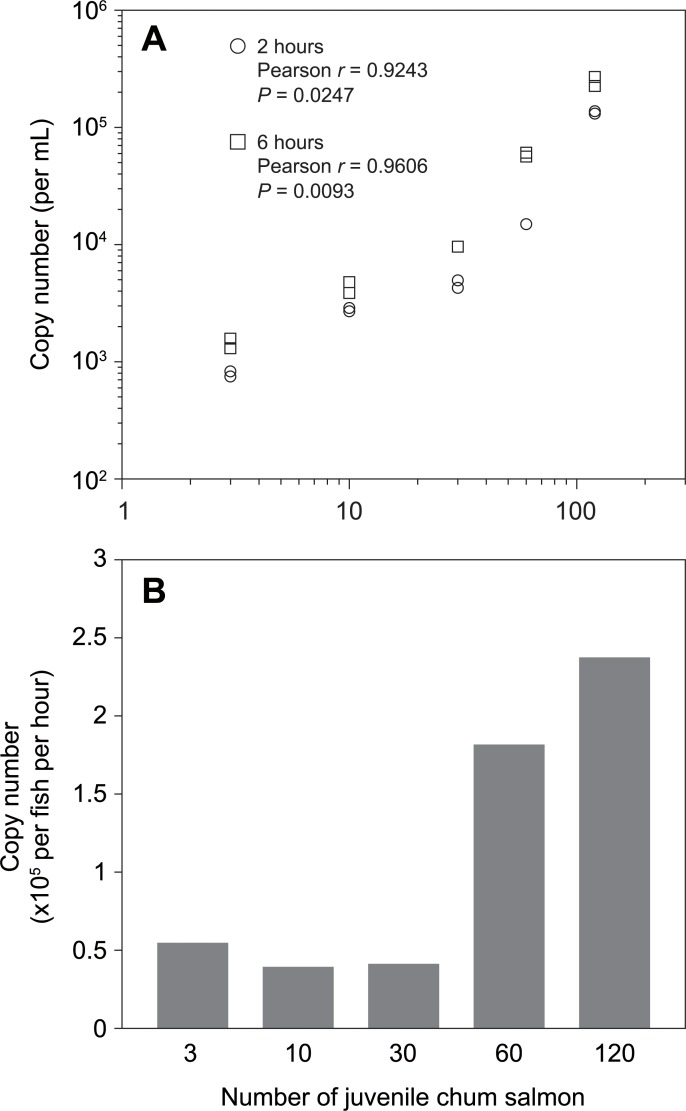
Relationships between the number of juvenile chum salmon and the eDNA amount.A, copy number per mL at two and six hours; B, the eDNA release rates per fish per hour.